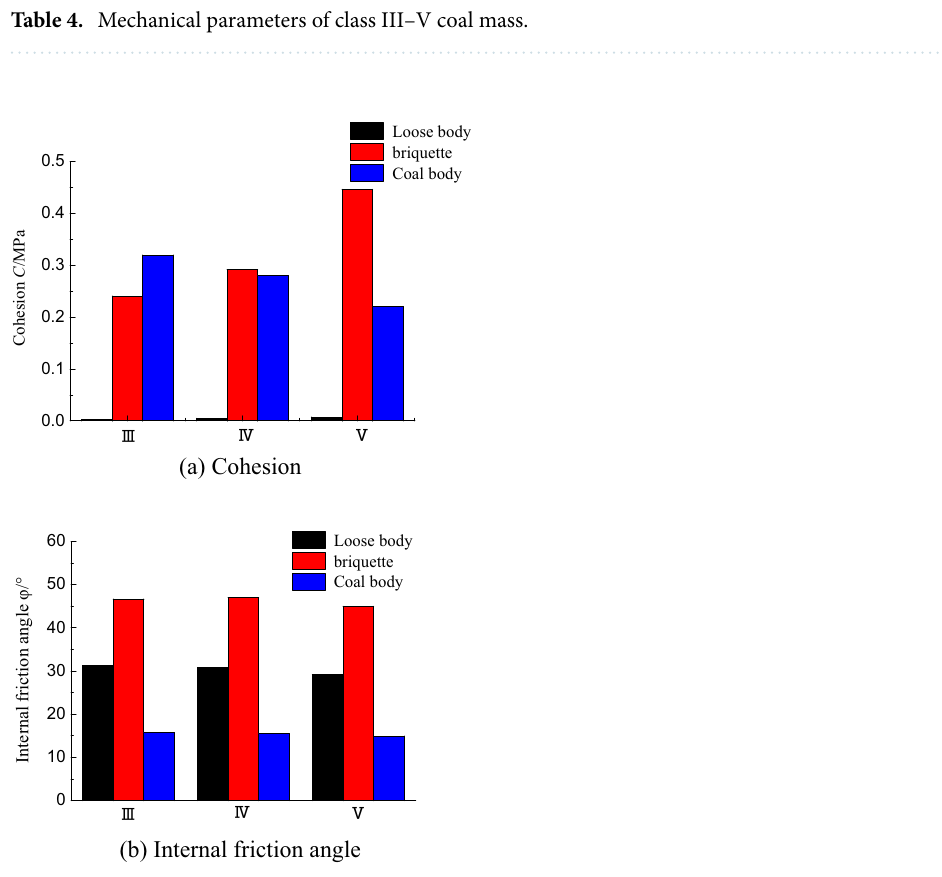
Figure 14. Bar graphs comparing the cohesion and internal friction angles of class III–V coal samples and coal